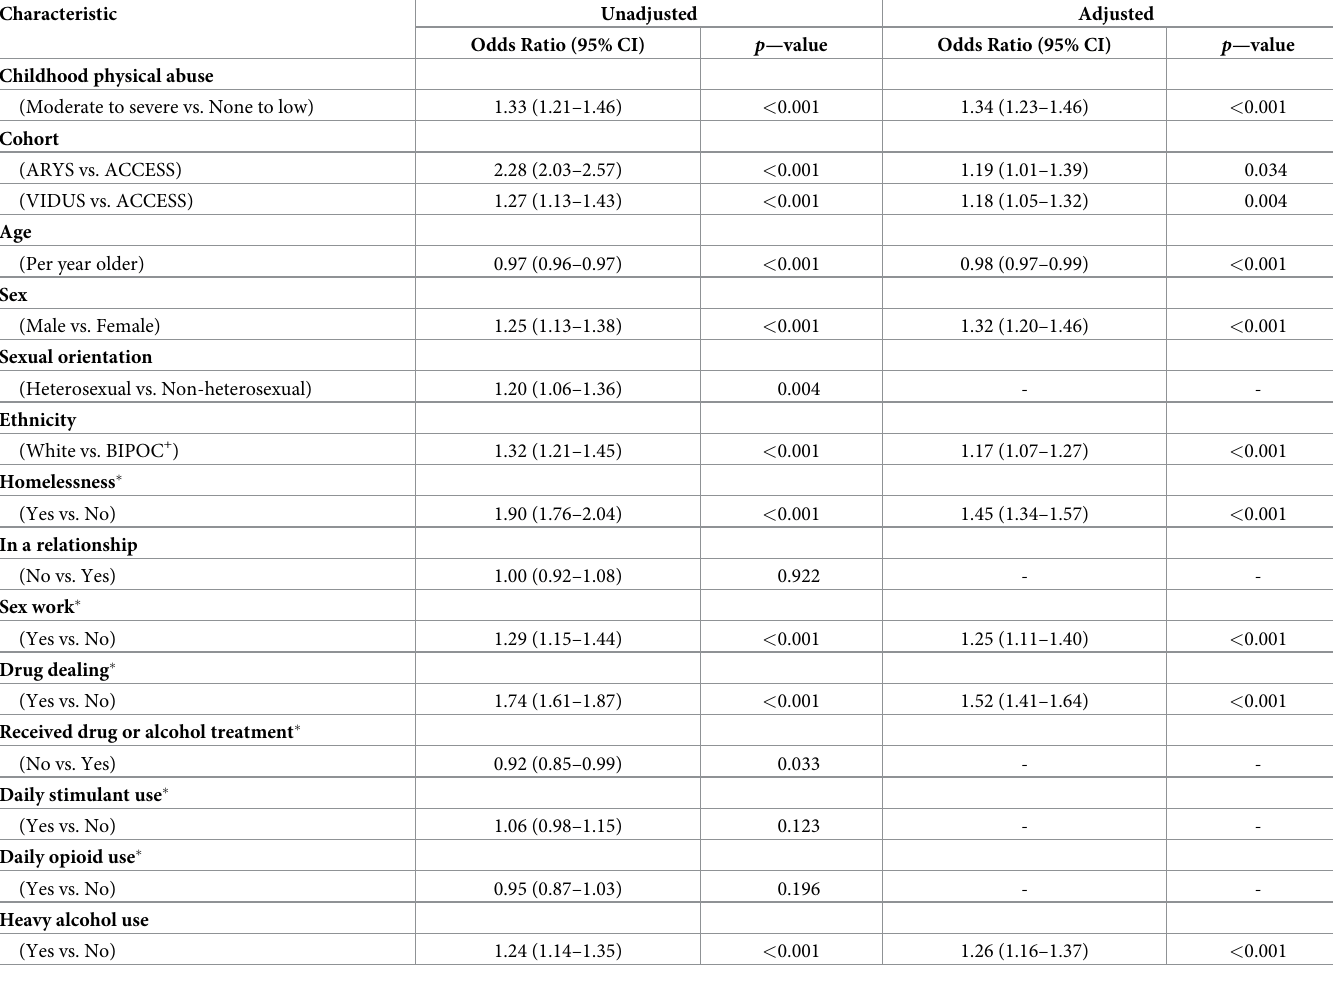
Table 2. Generalized linear mixed-effects analysis of factors associated with violent victimization among people who use illegal drugs in Vancouver, Canada (N = 2960).